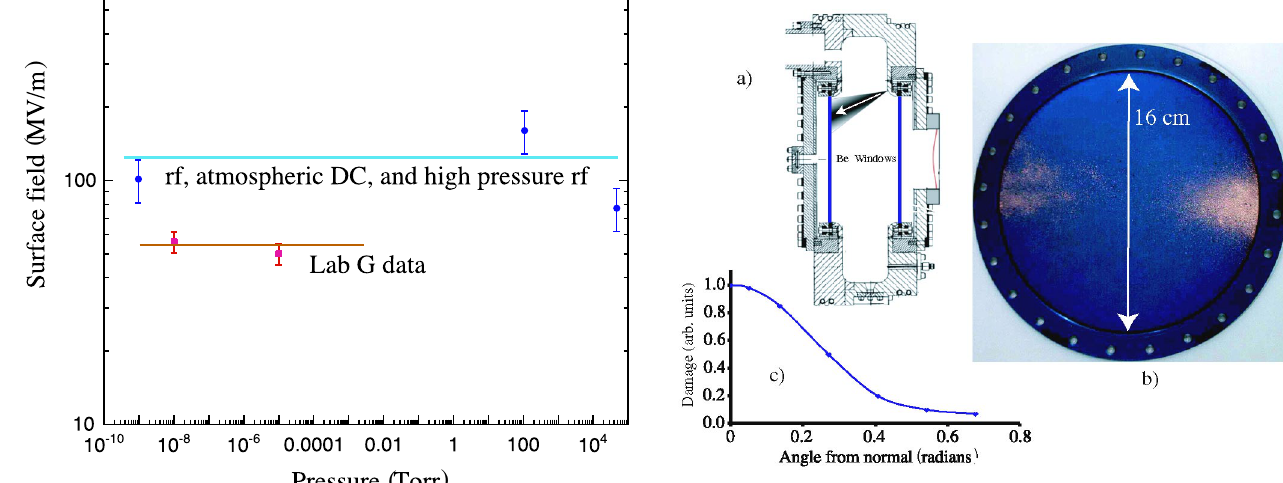
FIG. 17. (Color) Maximum surface fields as a function of pres- sure. Structures with smaller surface area seem to operate at slightly higher fields. Data are from Refs. [1,10,11,43].